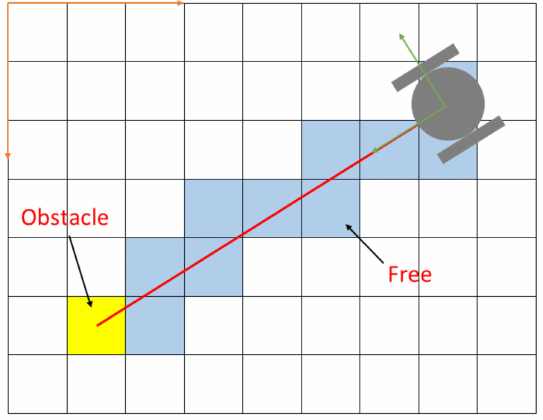
Figure 4. Schematic diagram of sensor inversion model. The yellow cell is the observed obstacle, and the blues are idle cells calculated by the Bresenham